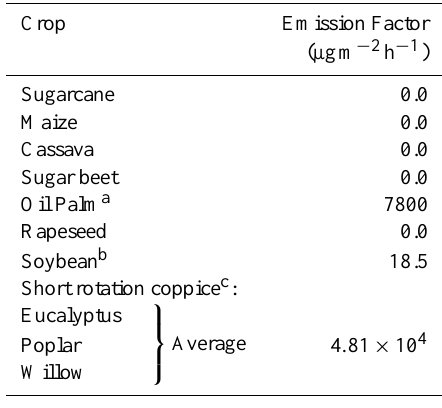
Table 3. Isoprene emission factors assumed for biofuel crops in this